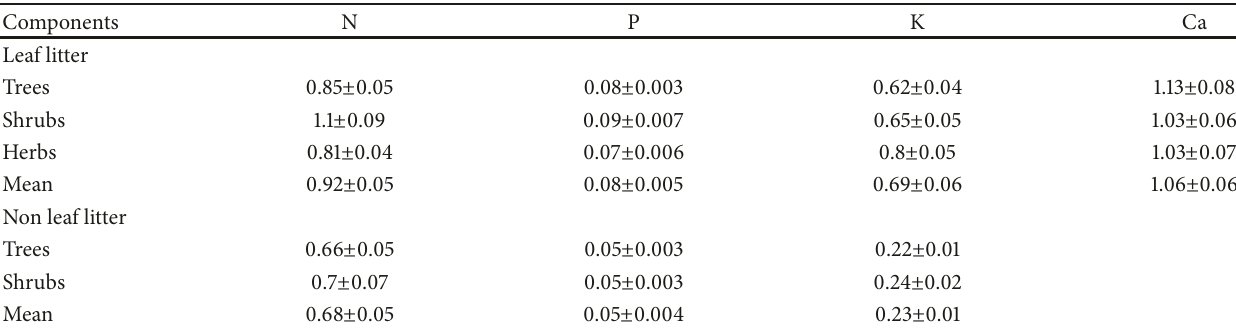
Table 7: Concentration of nutrients (%) (mean ± SE) in litter of moist tropical forest in Sunsari district, eastern Nepal.